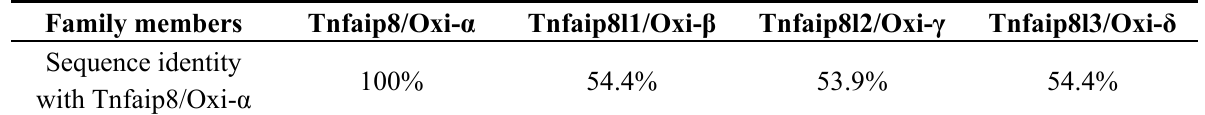
Table 1. Tnfaip8/Oxi- α family